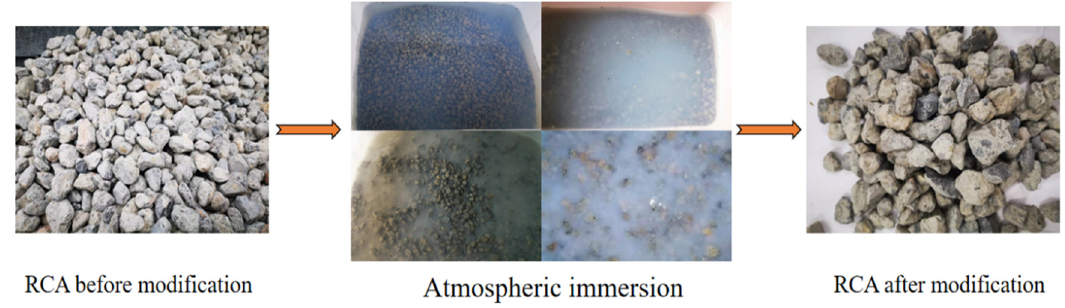
Figure 2: Schematic diagram of RA soaked in nano - SiO 2 at atmospheric pressure.